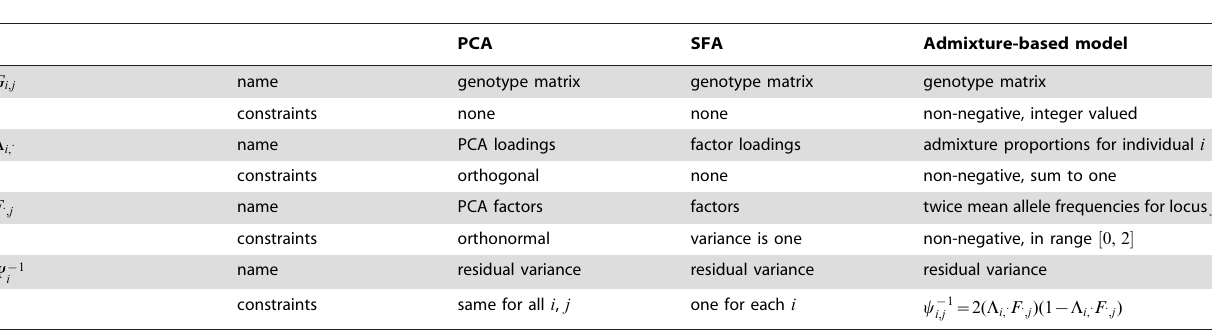
Table 1. Relationship of terms in PCA, SFA, and admixture-based models.